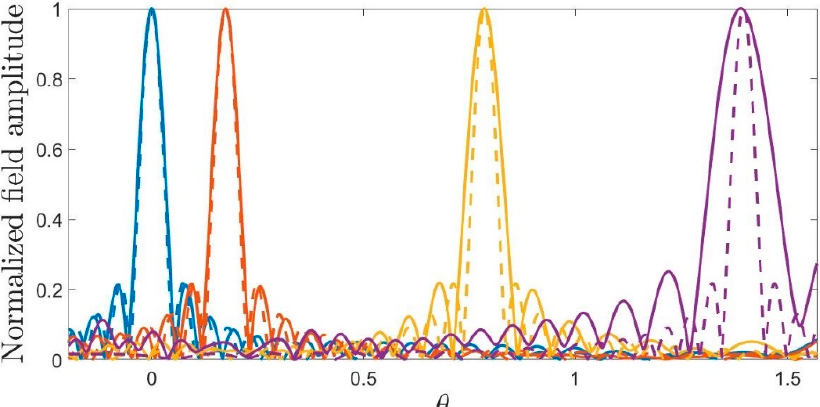
Figure 17. Normalized field amplitude of the desired field E ( θ ) (dashed curves) and the projected field (cid:101) E ( θ ) (solid curves) for the semi-elliptic source, varying the main beam angle θ 0 = 0, 0.17, 0.78, 1.4. The panels only zoom into a portion of the observation domain.